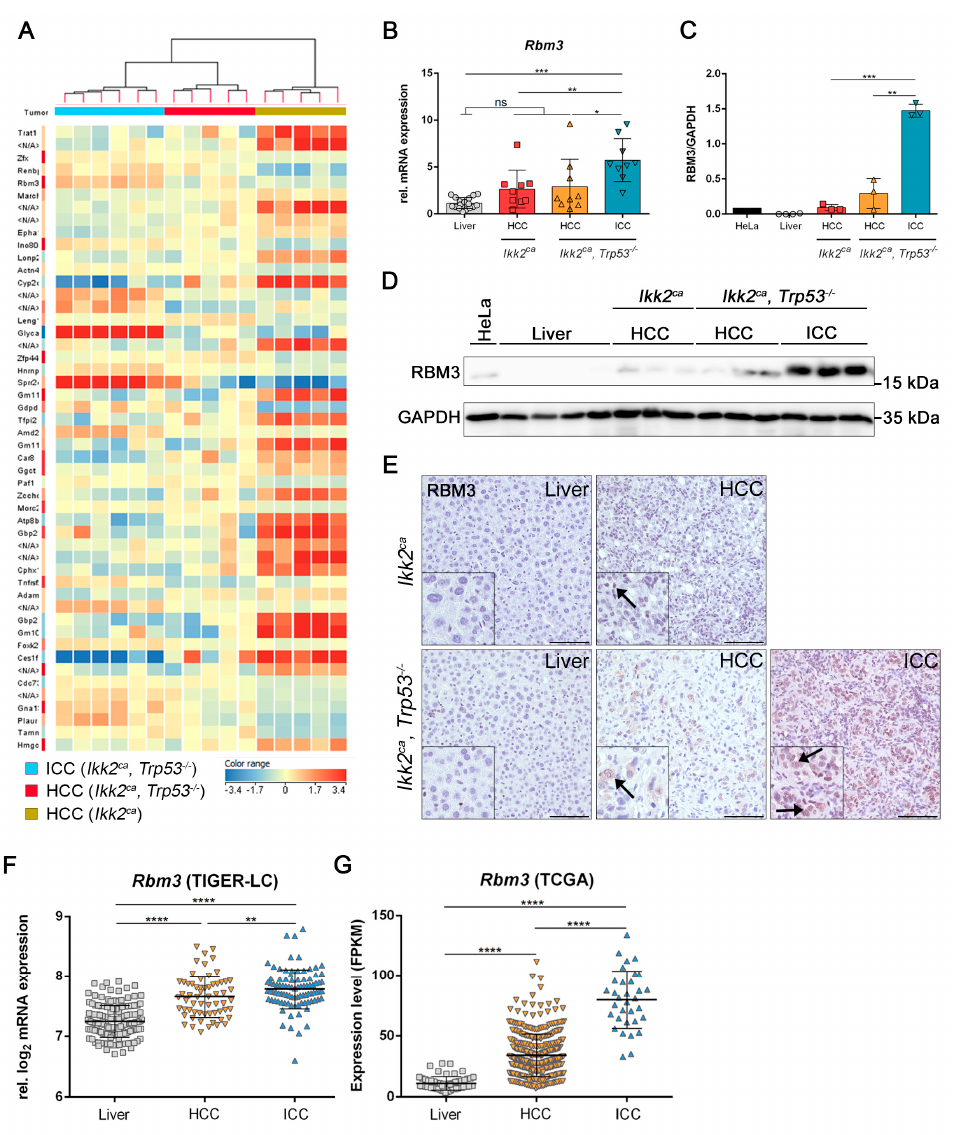
Figure 6. Transcriptome analysis of Ikk2 ca derived tumors. ( A ) Heatmap of expression profiles of the indicated group. ( B ) Combined scatter dot plot bar graph represents relative mRNA expression of Rbm3 in liver tissue from Trp53 +/+ , Trp53 − / − , Ikk2 ca and Ikk2 ca Trp53 − / − mice ( n = 3–5/genotype), HCC ( n = 9) form Ikk2 ca mice and HCC ( n = 9), ICC ( n = 9) from Ikk2 ca Trp53 − / − mice. ( C,D ) Graphs represent quantification ( C ) and western blot analysis ( D ) of RBM3 protein level in liver tissue from Ikk2 ca ( n = 2) and Ikk2 ca Trp53 − / − ( n = 2) mice, HCC ( n = 3) form Ikk2 ca mice and HCC ( n = 3), ICC ( n = 3) from Ikk2 ca Trp53 − / − mice. Protein lysate from HeLa cells was used as a positive control. ( E ) Representative images of RBM3 IHC in adjacent liver tissue and liver tumors from the Ikk2 ca and Ikk2 ca Trp53 − / − mice. Arrows point to RBM3 positive cells (scale bar: 100 µm). ( F ) Graphs represent relative gene expression values of Rbm3 in non-tumorous liver tissue ( n = 151), HCC ( n = 62) and ICC ( n = 91) from the TIGER-LC. ( G ) Graphs represent relative gene expression values of Rbm3 in non-tumorous liver tissue ( n = 58), HCC ( n = 371) and ICC ( n = 33) from the TCGA database (TCGA-LIHC and TCGA-CHOL). In ( F ) and ( G ) Mann-Whitney test was performed. All data represent the mean ± SD; * p < 0.05, ** p < 0.01, *** p < 0.001, **** p < 0.0001.